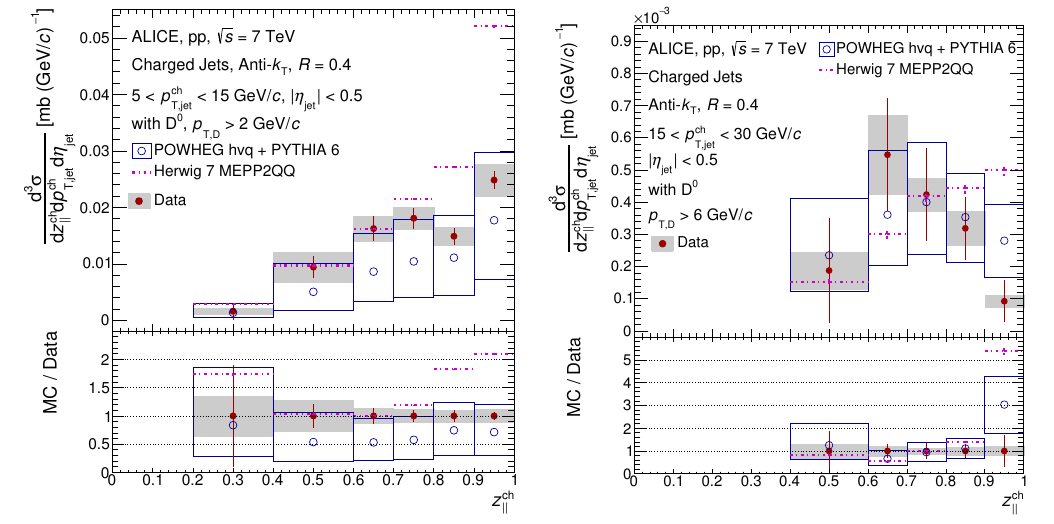
Figure 7 . z ch -di(cid:11)erential cross section of D 0 -meson tagged track-based jets in pp collisions at jj p s = 7 TeV with 5 < p ch < 15 GeV =c (left) and 15 < p ch < 30 GeV =c (right). The solid T ; jet T ; jet red circles show the data with their systematic uncertainties represented by gray boxes. The measurements are compared with the POWHEG heavy-quark implementation (open circles) and with Herwig 7 MEPP2QQ (dashed-dotted lines).